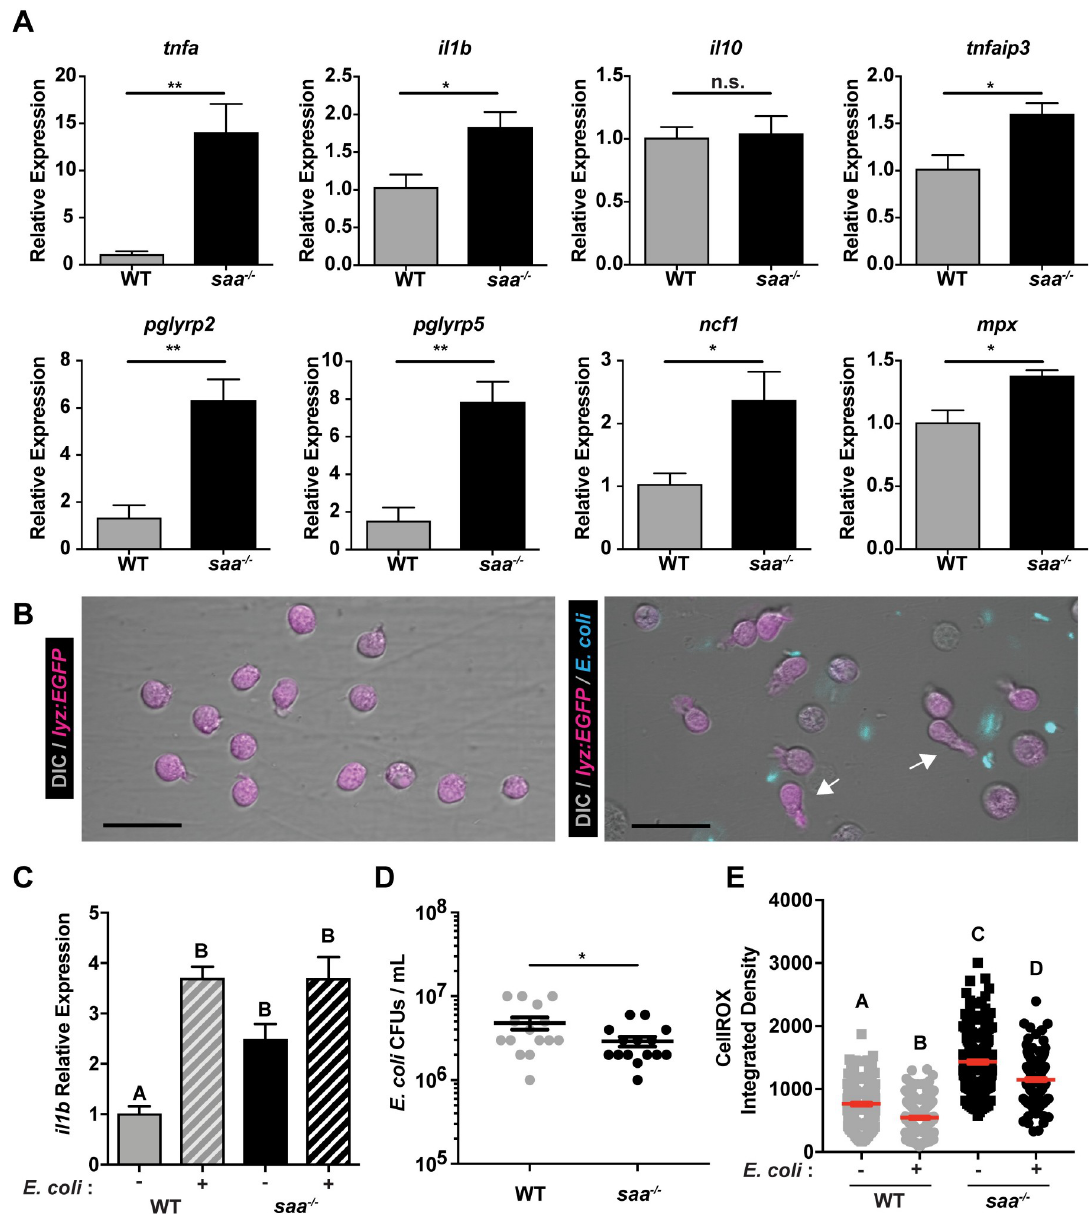
Fig 3. Saa suppresses neutrophil transcriptional activation and bactericidal activity. (A) qRT-PCR of pro-inflammatory mRNAs from sorted neutrophils from 6 dpf WT and saa mutant zebrafish larvae (5,000–12,000 lyz:EGFP + cells / replicate, 3–6 replicates / genotype / experiment, 60–90 larvae / replicate). (B) Microscopic analysis revealed neutrophils isolated from adult zebrafish kidneys extend protrusions in response to bacterial signals ex vivo (white arrows; scale bar = 20 μ m). (C) il1b expression in un-stimulated and E . coli exposed lyz:EGFP + neutrophils from WT and saa mutant zebrafish following 4 hours ex vivo culture (3–5 replicates / genotype / condition). (D) CFU quantification of bacterial concentration following 4 hour co-culture of isolated lyz:EGFP + neutrophils from WT and saa mutant zebrafish with E . coli (MOI 2). (E) Quantification of intracellular ROS levels by CellROX fluorescence from neutrophils cultured ex vivo with and without E . coli (lyz:EGFP + cells isolated from 6 zebrafish adult kidneys / genotype, quantification of � 177 cells / condition). In panels C and E, a one-way ANOVA with Tukey’s multiple comparisons test was used. Data in panels A and D were analyzed with a t- test. Data are presented as mean ± SEM. � p < 0.05, �� p < 0.01, ��� p < 0.001, ���� p <